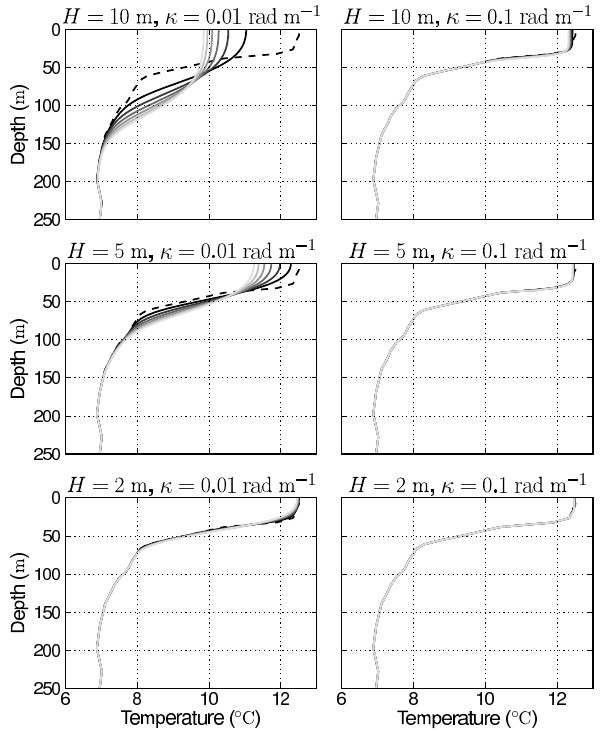
Fig. 4. As for Fig. 3 but for a wider range of wave heights and wave numbers.